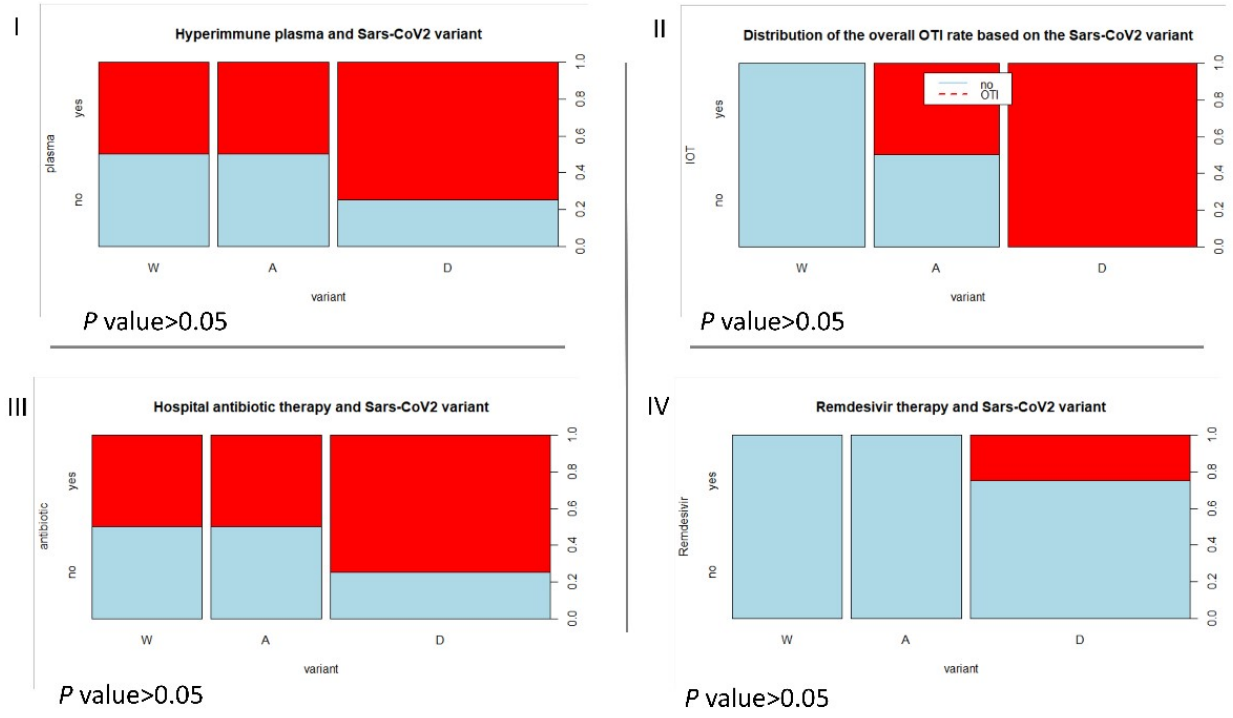
Figure 1. ( I ) The different therapy performed (in red) during the step-up stay of severe-critical COVID-19 pregnant women based on the variant (W = wild, A = alpha, D = delta). Half of W and A underwent hyperimmune plasma and antibiotic therapy, whereas in D the percentage rose to 75%. ( II ) None of the W patients underwent OTI, whereas half of the A and all the D patients needed it. ( III ) the different therapy performed (in red) during the step-up stay of COVID-19 affected pregnant women based on the variant (W = wild, A = alpha, D = delta). ( IV ) None of the W and A patients underwent remdesivir, whereas 33% of D needed it. The graphs represent a descriptive comparison of the variables’